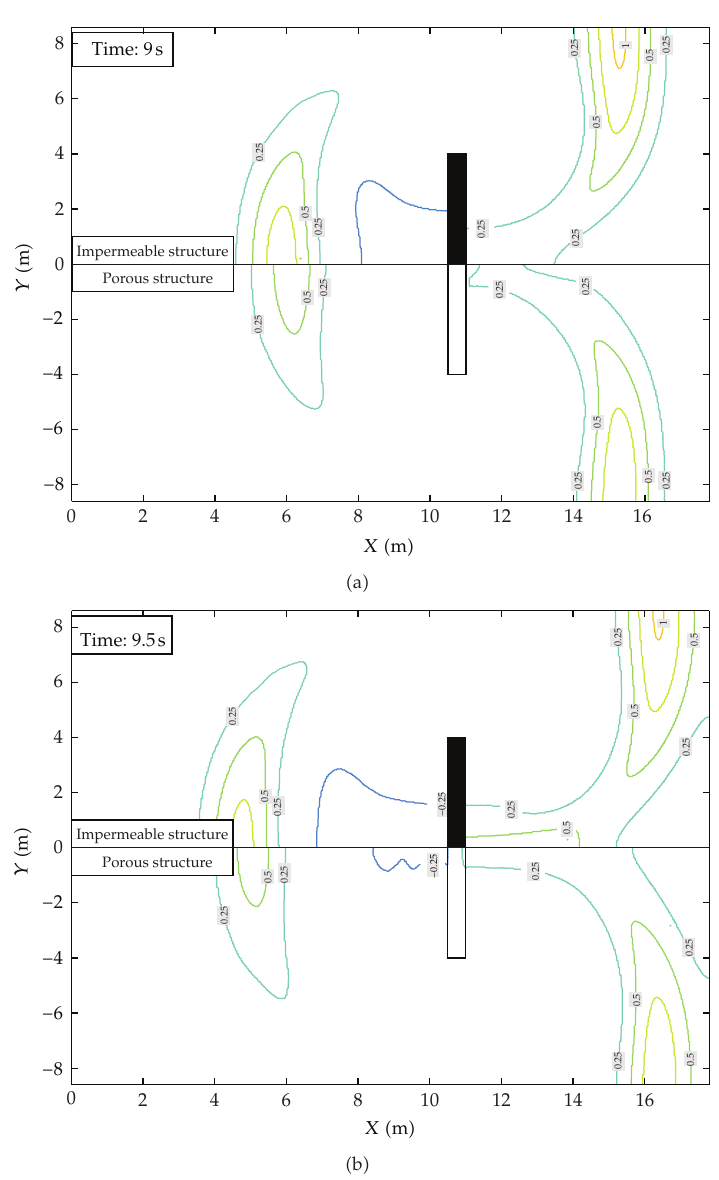
Figure 7: Free surface elevation isolines for the impermeable and porous structure under the action of the solitary wave case of height H (cid:7) 9cm and water depth h (cid:7) 40cm, part III. is sticked to the leeward side of the structure, while a depression is present in the seaward side. In the porous simulation, the 0 . 25 isoline is not in touch with the structure anymore. Free surface elevation, however, is lower in the leeward face of the porous structure, but no depression is found in the seaward face. This clearly shows that the di ff erences in wave di ff raction are due to the link between the leeward and seaward faces that is established by the porous